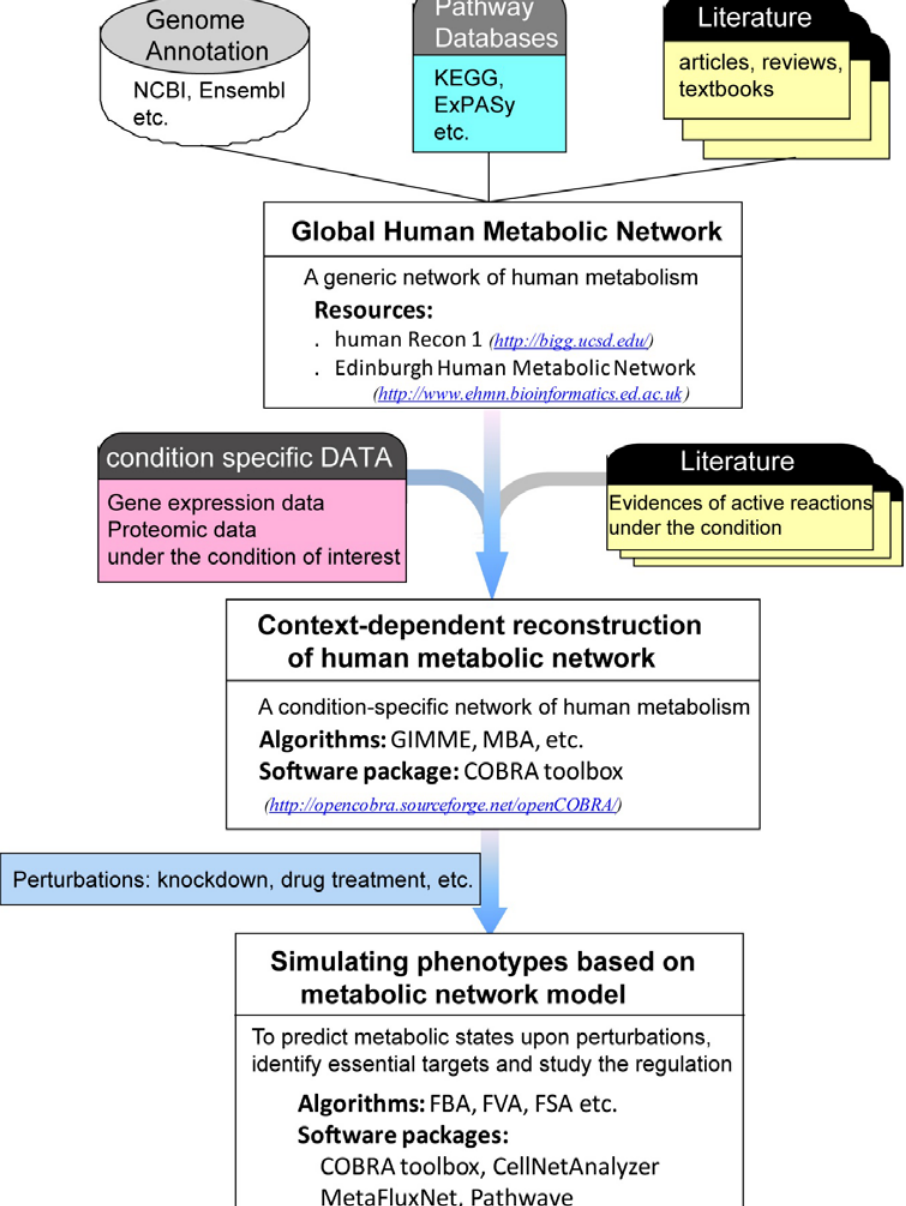
Figure 1. A pipeline for systems biology applications of human metabolic network. The global human metabolic network integrates literature and genomic information (including gene annotations, reactions and pathways) to provide a platform for systematic analysis and modeling. Condition-specific omics data and literature information can be incorporated into a platform to reconstruct context-dependent metabolic networks. Modeling and simulation based on context-dependent metabolic network can then be used to predict metabolic states under various perturbations, help identify gene targets and study regulation of the human metabolic system. Softwares listed in the figure: COBRA [24]: The COnstraints Based Reconstruction and Analysis toolbox. CellNetAnalyzer [25]: structural and functional analysis of biochemical networks. MetaFluxNet [26]: Analysis of metabolic fluxes in an interactive and customized way. Pathwave [27]: Identification of differentially regulated enzymes in metabolic